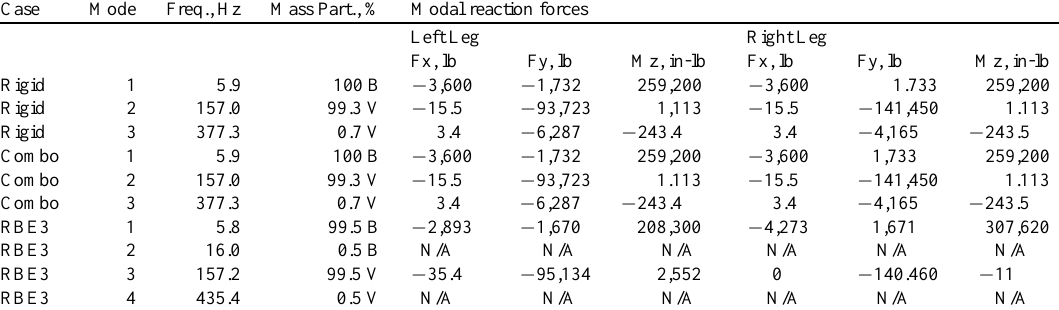
Table 8 Shock analysis results for other cases; Asymmetric